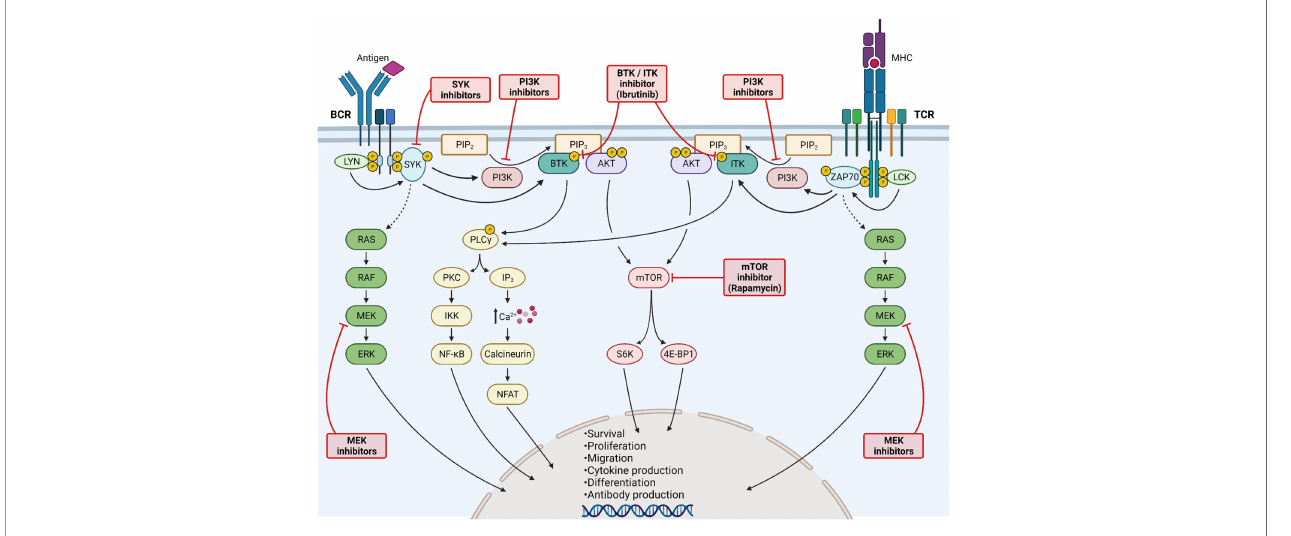
FIGURE 3 | Kinase inhibition for Graft- versus -Host Disease treatment. Activation of B-cell (left side) and T-cell (right side) receptors leads to LYN/LCK phosphorylation, subsequently phosphorylating SYK and ZAP70. Both kinases further increase the downstream RAS/RAF/MEK/ERK signaling cascade. Activated SYK/ZAP70 stimulates also PI3K, as well as BTK and ITK. PI3K catalyzes the transformation of PIP 2 into PIP 3 , being a binding site for BTK/ITK and AKT. BTK and ITK phosphorylate PLC g , thereby enhancing PKC signaling and NF- k B translocation into the nucleus. Moreover, elevated calcium in fl ux activates NFAT signaling. Activation of AKT stimulates mTOR signaling. All major kinase signaling pathways lead to cell survival, proliferation, differentiation and migration. Furthermore, cytokine and antibody production are enhanced. The signaling pathways can be blocked at various steps, including MEK, SYK, PI3K, BTK/ITK and mTOR inhibition. All kinase inhibitors have shown promising results in GvHD. Created with